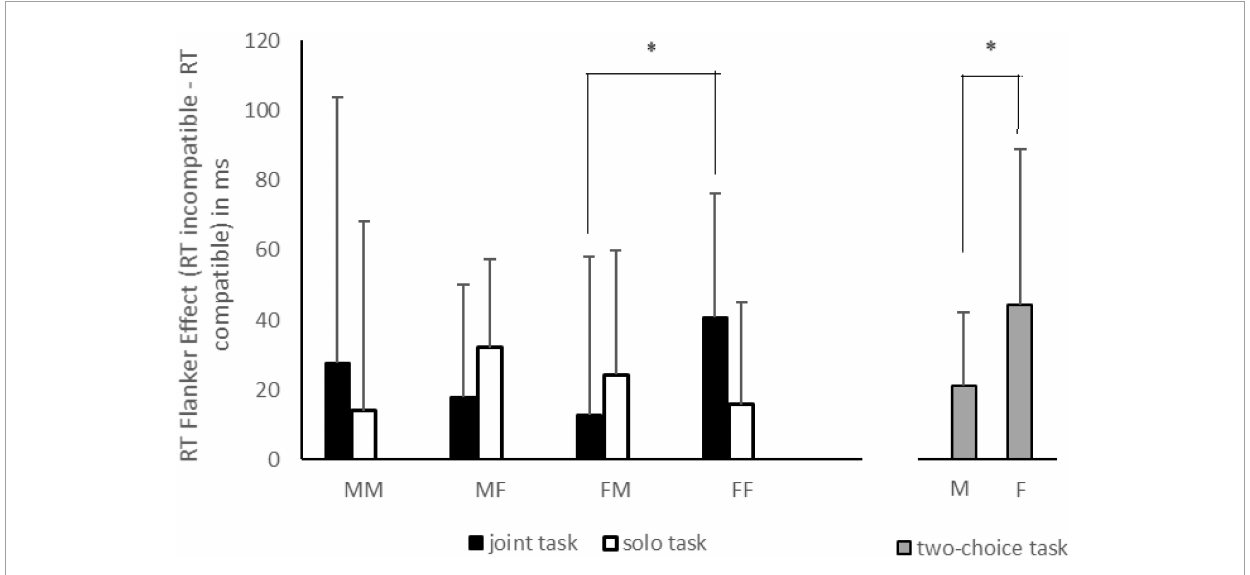
FIGURE1 The flanker effect (FE), reported as the difference between response times (RTs) of incompatible and compatible trials for each sex pair (MM, male-male; MF, male-female; FM, female-male; FF, female-female) in joint (black histograms) and solo (white histograms) tasks. The gray histograms represent the FE for males and females in a classical two-choice task. The asterisks indicate the significant comparisons. The bars represent the standard